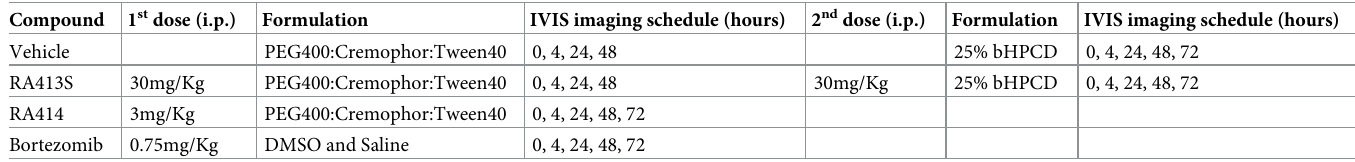
Table 2. Dosing regimen of compounds and IVIS imaging schedule. 5 CD1 mice were imaged per compound. (bHPCD = β -hydroxypropyl cyclodextrin). Compound 1 st dose